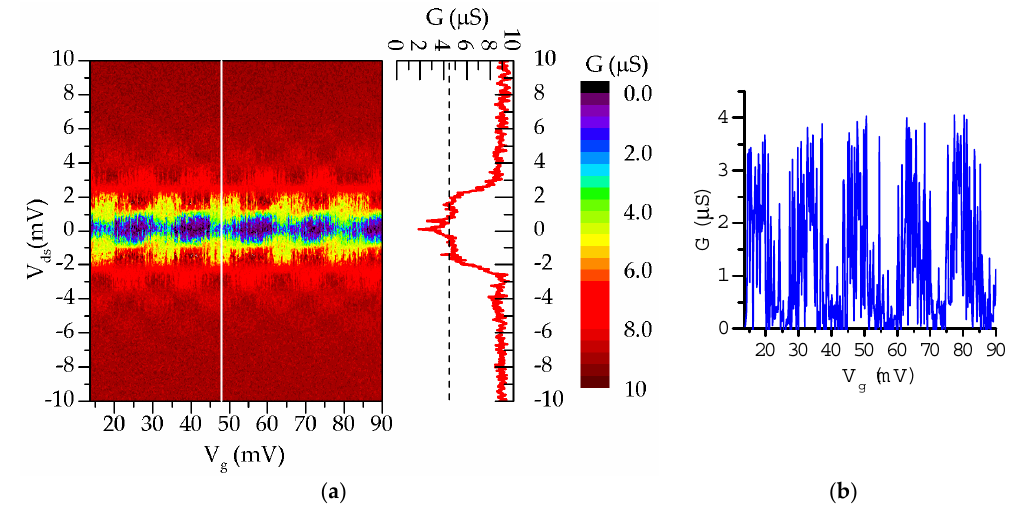
Figure 17. ( a ) Typical Coulomb diamond plot for a Ni ‐ SiN x ‐ Ni SET with 21 cycles of SiN x (~1 nm) along with a G ( V d s ) cross section at V g = 47 mV (a peak of CBOs); and ( b ) CBOs from the same device exhibiting RTS noise.